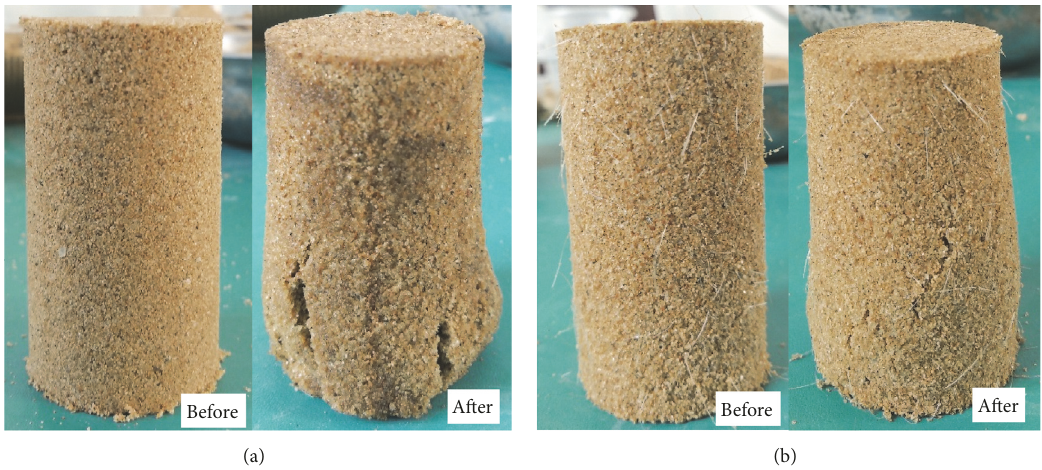
Figure 5: Photos of samples before/after test. (a) Polymer 1%-fiber 0%; (b) polymer 1%-fiber 0.2%.